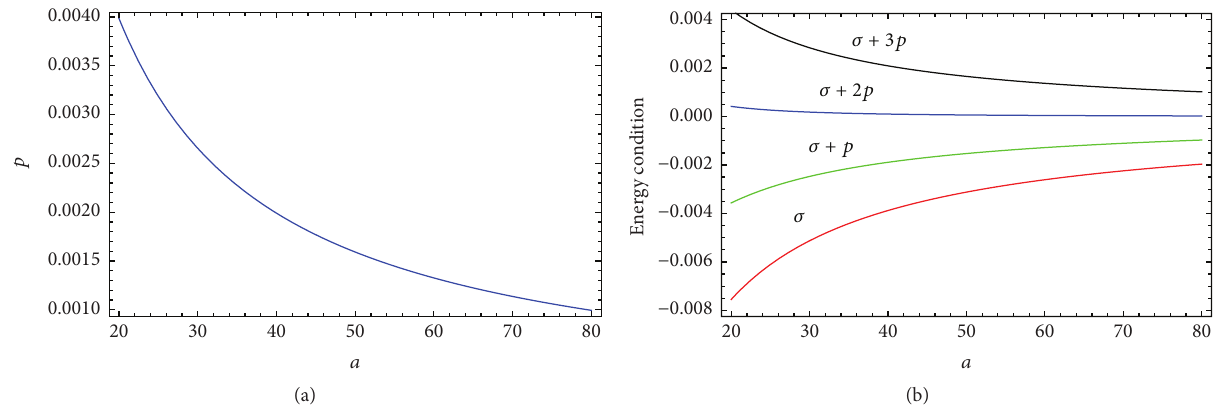
Figure 1: Plots of 𝑝 and energy conditions with 𝑀 = 1 and 𝑙 = 0.9